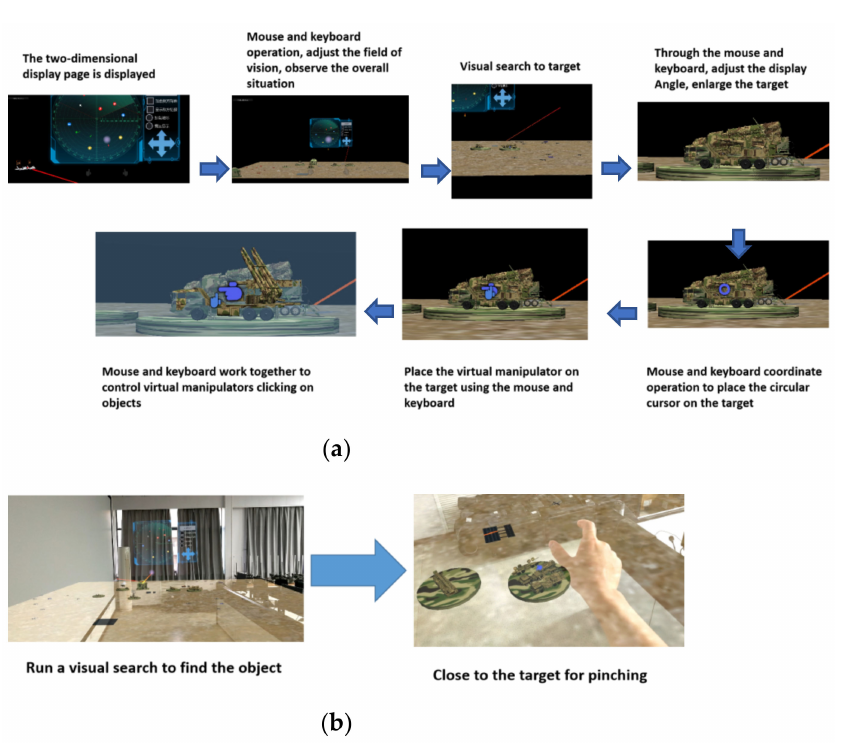
Figure 10. Interactive operation method diagram (( a ) The operation process in 2D display; ( b ) Operation process in MR